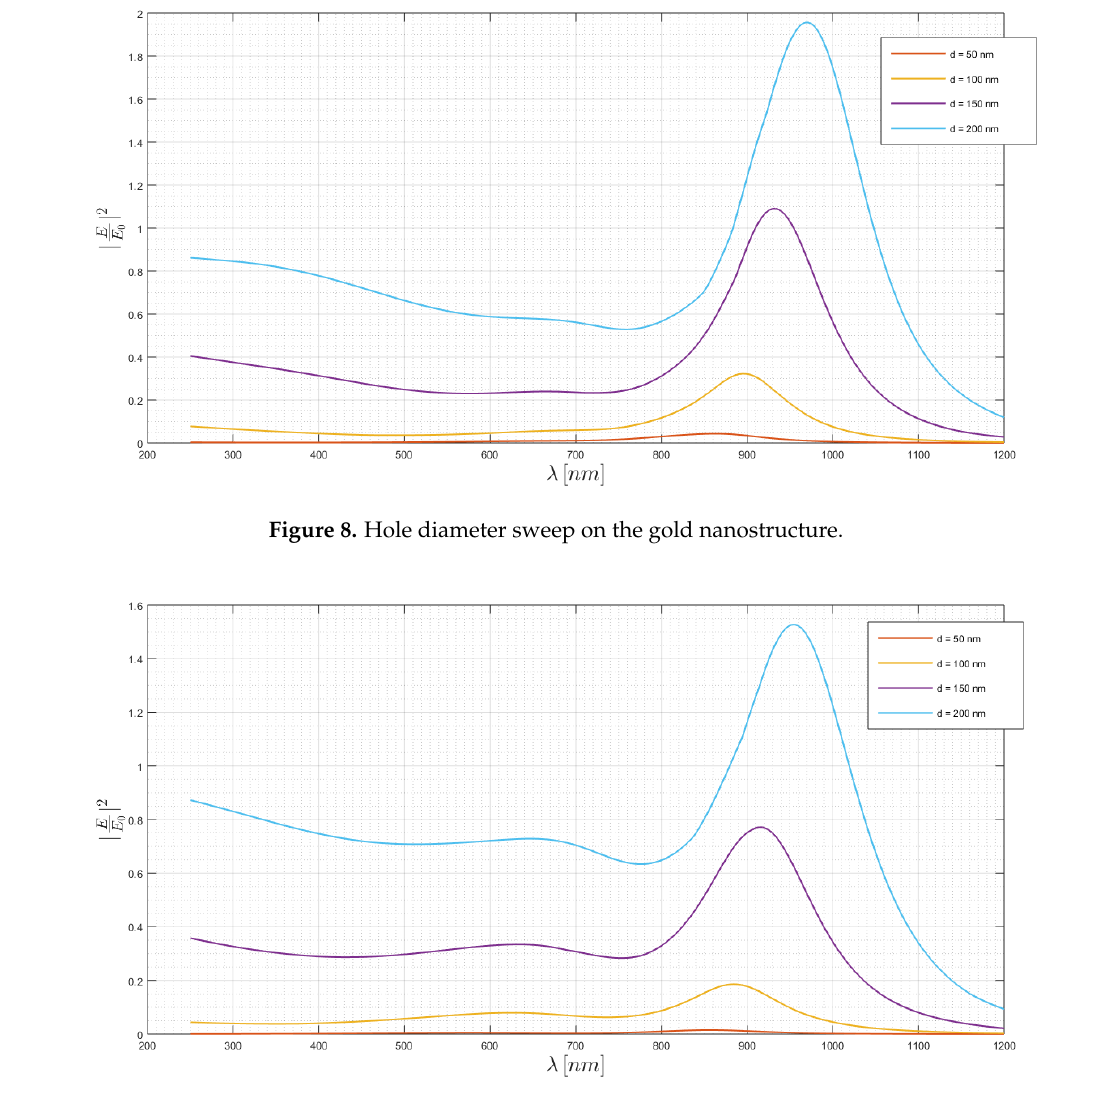
Figure 9. Hole diameter sweep on the copper